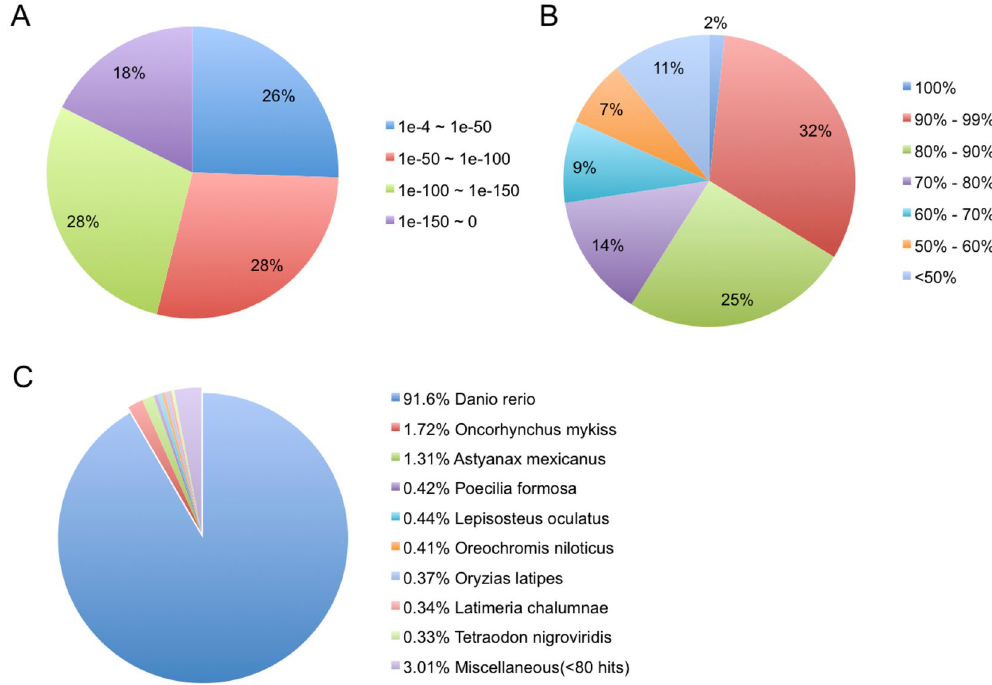
Figure 1. Annotation summary of assembled Carassius auratus RGC genes against the UniProt database. ( A ) E-value distribution of BLASTX hits for each transcript with an E-value cut off of 1e-4. ( B ) Similarity distribution of BLATX hits for each gene. ( C ) Distribution of the top BLASTX species hits in the UniProt